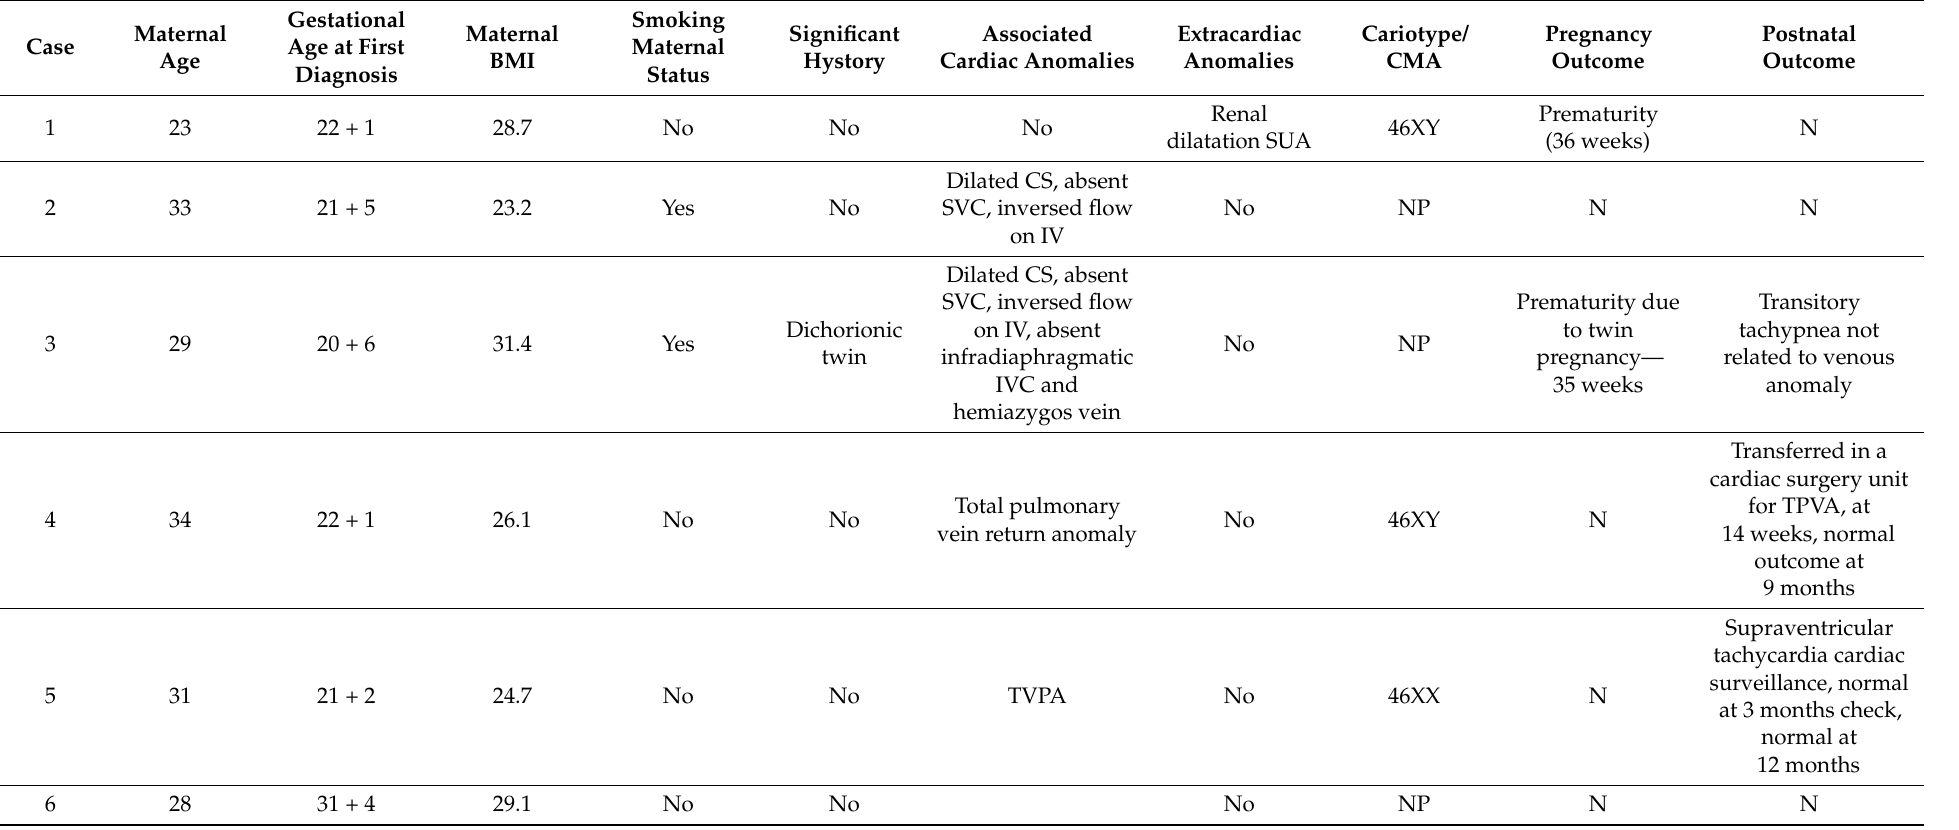
Table 1. Main characteristics of the